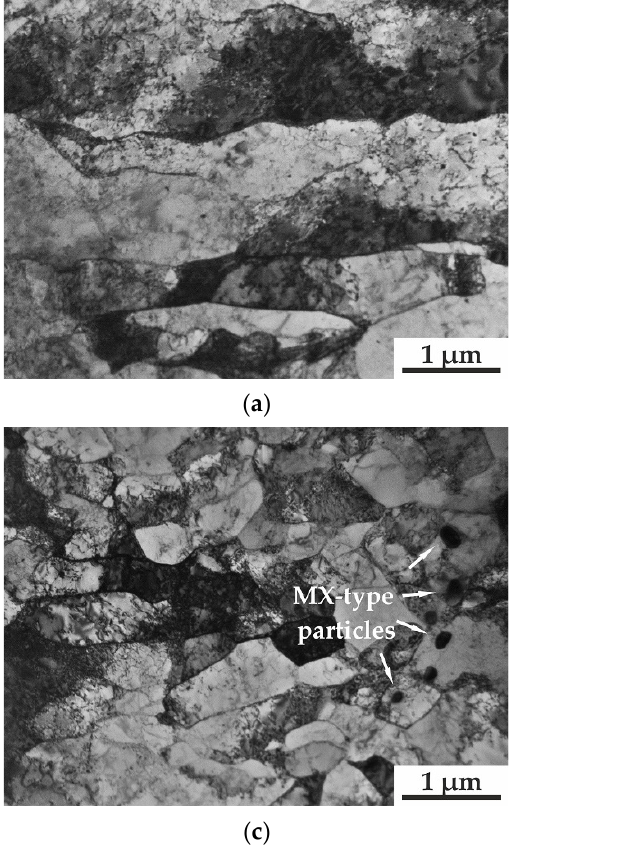
Figure 3. Transmission electron microscopy (TEM) images of steel microstructure after HTMT-1. Bright-field (BF) image ( a ), selected area electron diffraction (SAED) pattern with marked zone axis [112] γ ( b ), BF image with MX particles marked by arrows ( c ), SAED pattern with marked zone axis (ZA) [110] γ ( d ).